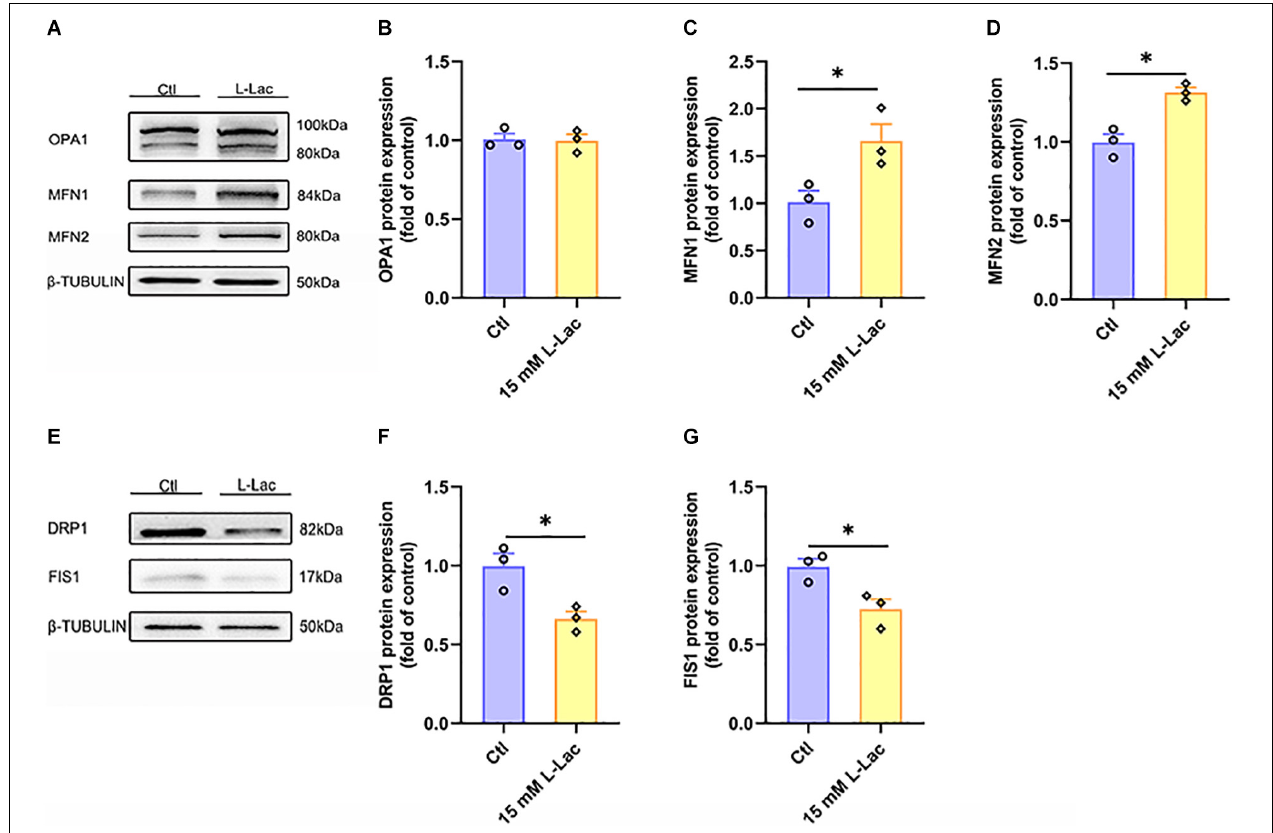
FIGURE 9 | Lactate directly regulated mitochondrial fusion and fission in primary hippocampal cells. The Optic atrophy (OPA1), Mitofusin 1 (MFN1), and Mitofusin 2 (MFN2) were determined by WB to observe the effect of lactate on the mitochondrial fusion in primary hippocampal cells. The Dynamin-related protein1 (DRP1) and mitochondrial fission 1 protein (FIS1) were also determined by WB to observe the effect of lactate on the mitochondrial fusion in primary hippocampal cells. (A,E) Representative WB image. (B) OPA1 protein expression. (C) MFN1 protein expression. (D) MFN2 protein expression. (F) DRP1 protein expression. (G) FIS1 protein expression. TUBULIN as the loading control. N = 3 in three independent experiments. ∗ P ≤ 0.05 as compared with the Ctl group by non-parametric tests. Values are expressed as mean ± standard error of the